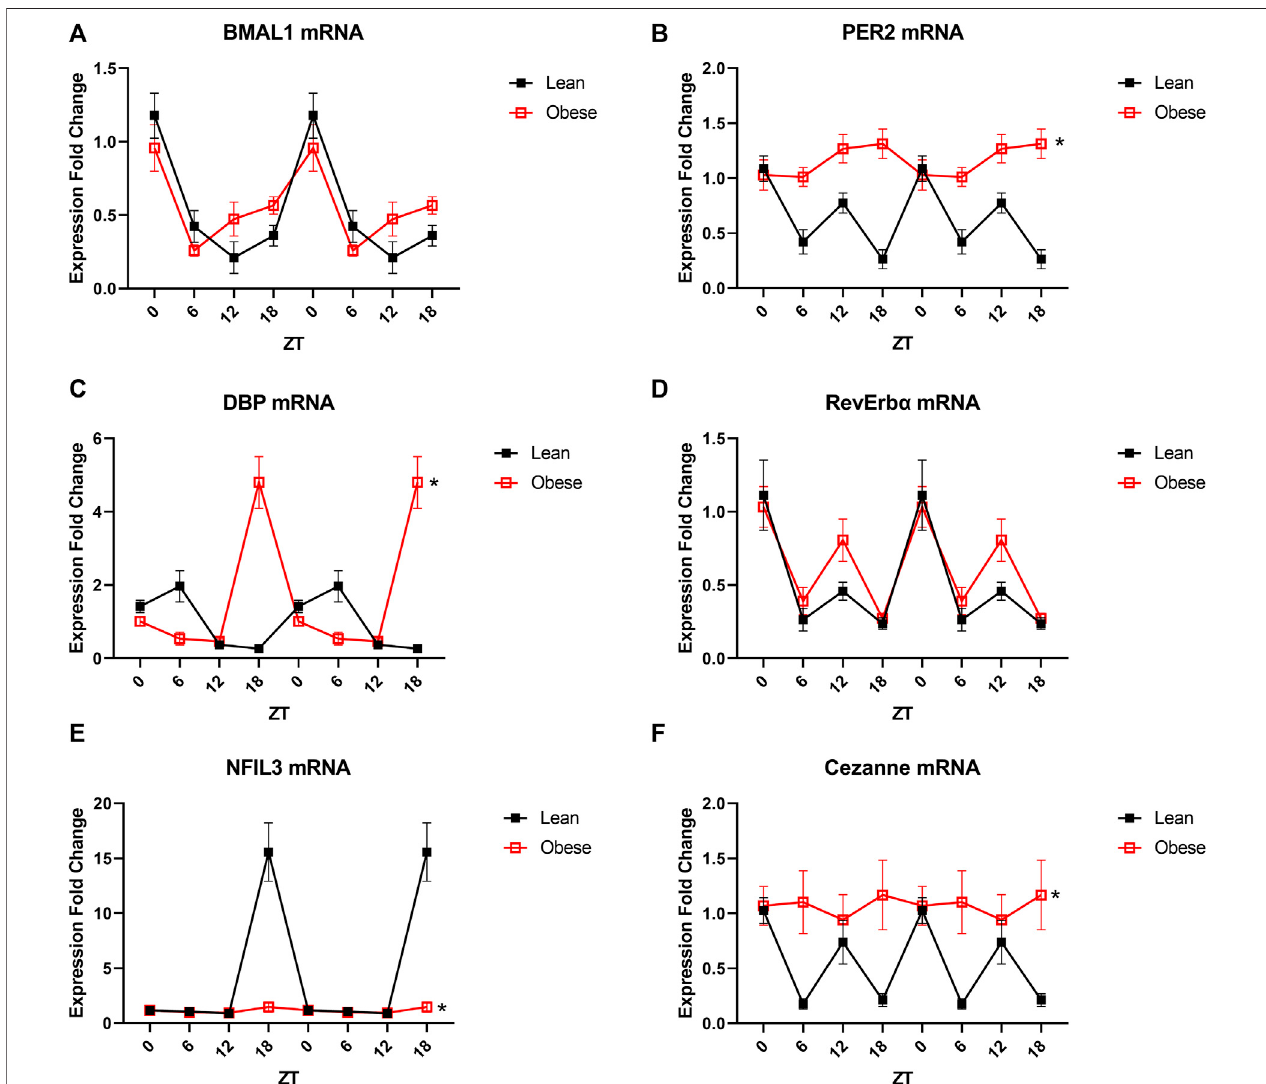
FIGURE 3 | Obesity partially alters the transcriptional pro fi le of endothelial cells. (A). BMAL1 mRNA levels in freshly isolated mesenteric endothelial cells from male 20-weekold lean ( db/+ ) and obese ( db/db )mice( n = 3 – 6). (B). PER2 mRNA levels in freshly isolated mesenteric endothelial cells from male 20-week old lean ( db/+ ) and obese ( db/db )mice ( n =3 – 6). (C). DBP mRNA levels infreshly isolated mesentericendothelial cells frommale20-weekoldlean ( db/+ ) and obese( db/db )mice ( n = 3 – 6). (D). RevErb α mRNA levels in freshly isolated mesenteric endothelial cells from male 20-week old lean ( db/+ ) and obese mice ( db/db ) ( n = 3 – 6). (E). NFIL3